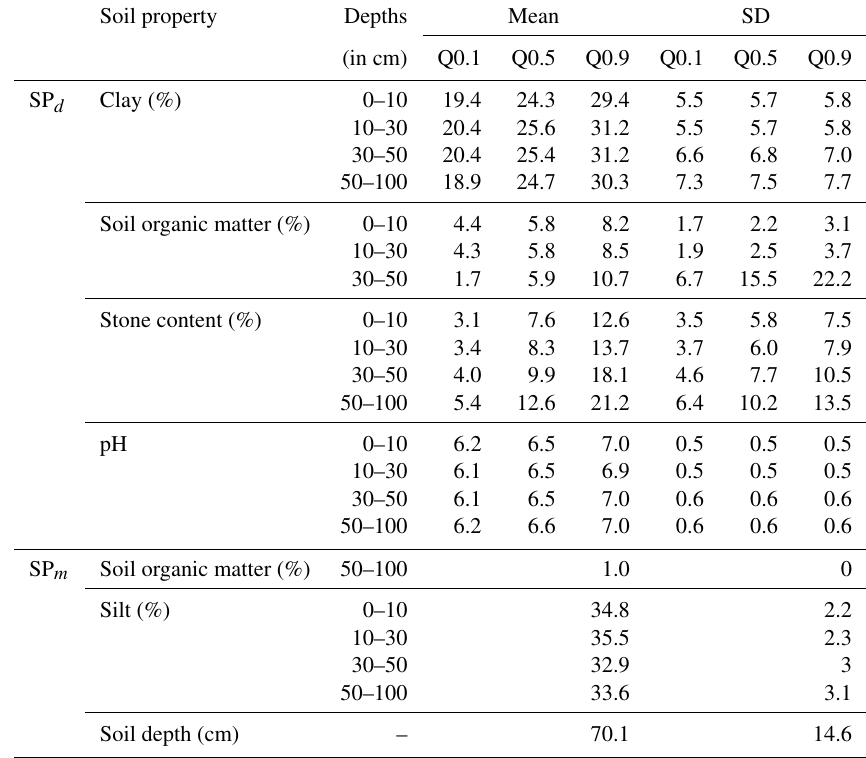
Table 2. Summary statistics of modeled soil properties generated by the DSM approach by Nussbaum et al. (2017) for the Greifensee study